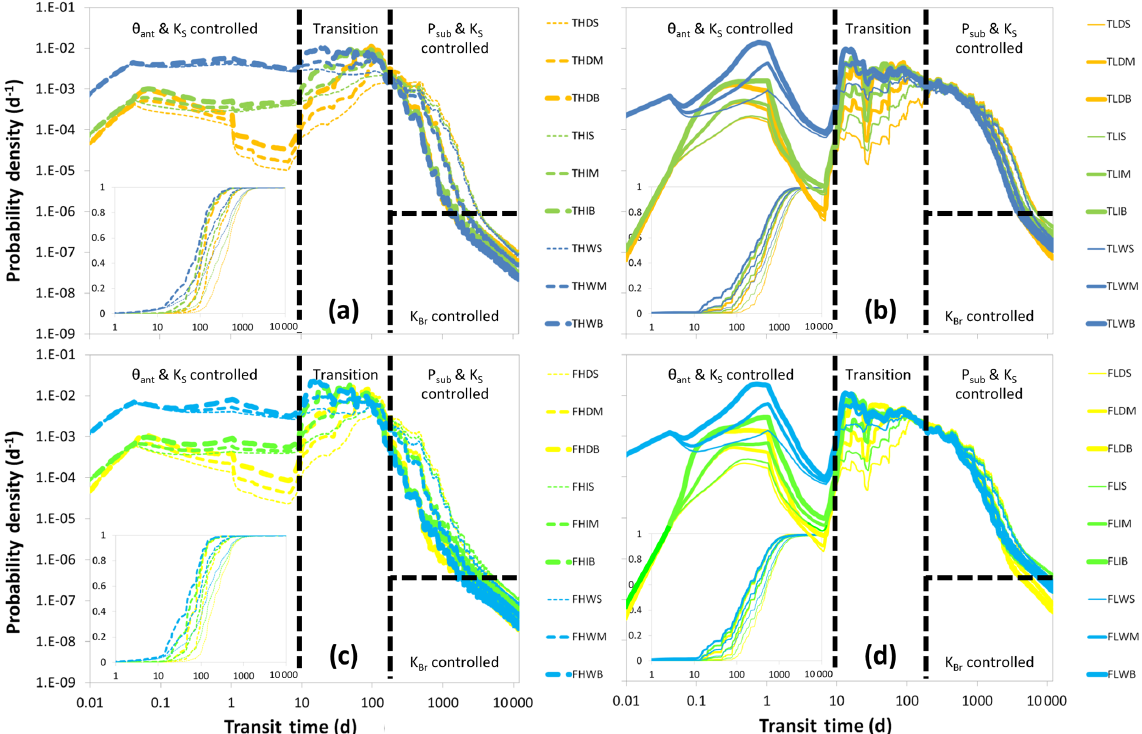
Figure 7. Results of the 36 model runs. TTDs are grouped by soil depth ( a and b = deep (thick); c and d = shallow (flat)) and soil hydraulic conductivity ( a and c = high; b and d = low). Yellow colors indicate dry, green intermediate and blue wet antecedent moisture conditions; thick lines indicate large, mid-sized lines medium and thin lines small amounts of subsequent precipitation amounts. Dashed black lines divide TTDs into four parts, each part controlled by different properties. Note the log–log axes. Insets show cumulative